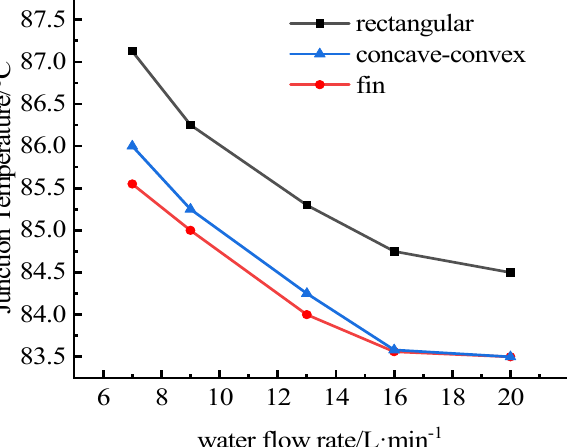
Figure 12. Relations between water flow rate and the junction temperatures of IGBT chips.